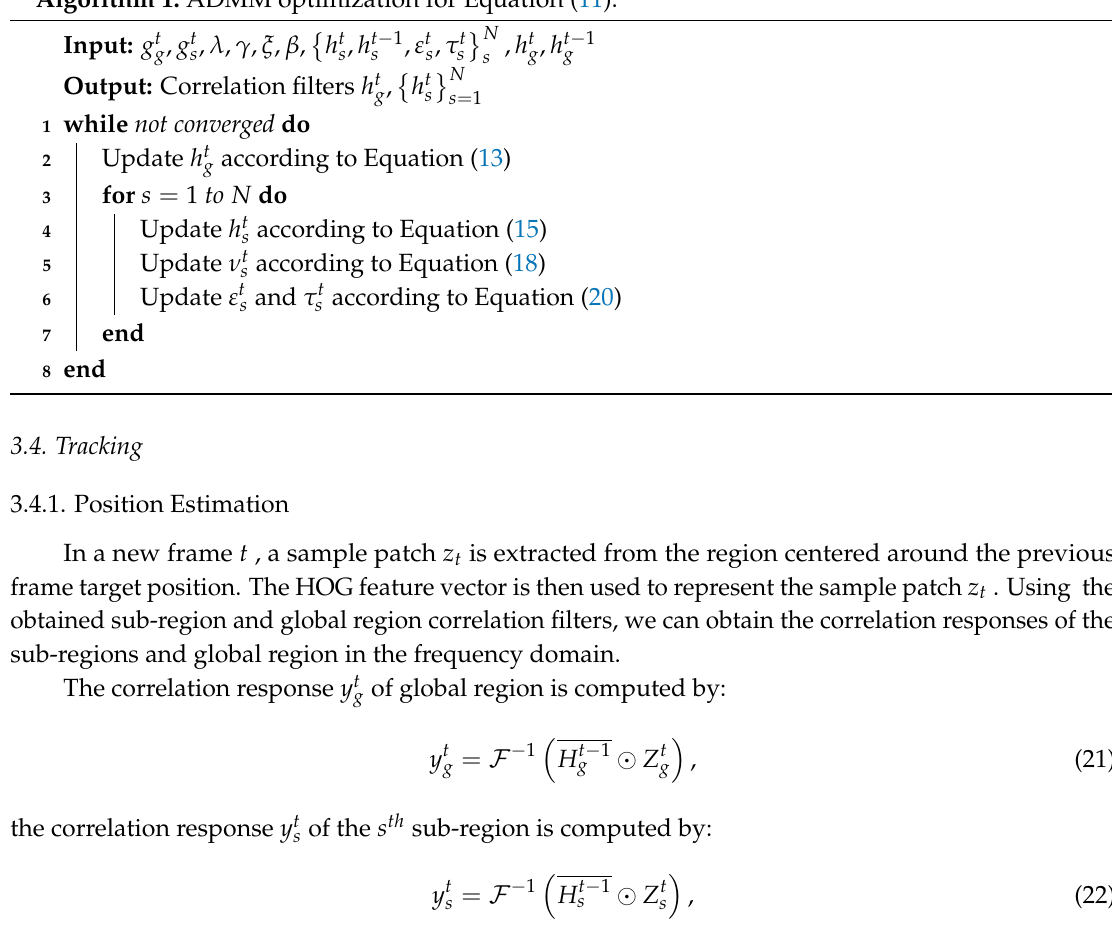
Algorithm 1: ADMM optimization for Equation